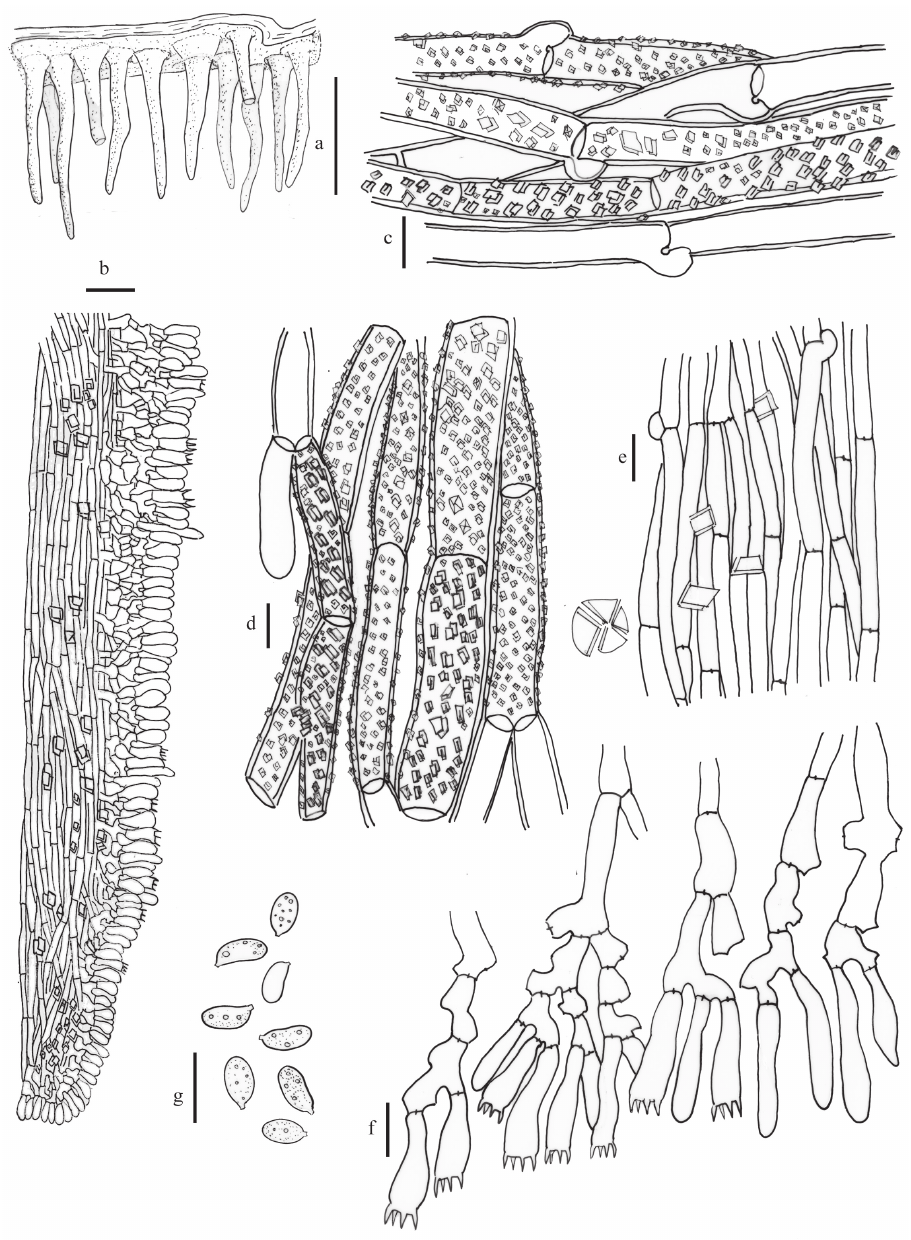
Figure 5. Hydnophlebia chrysorhizon . Collection NY, lectotype a Hymenophore b Vertical section through an aculei c Subicular hyphae d Strand hyphae e Aculei hyphae f Subhymenial hyphae and basidia g Spores. Scale bars: a = 1mm; b = 25 μm; c–g = 10 μm. Drawing by M.